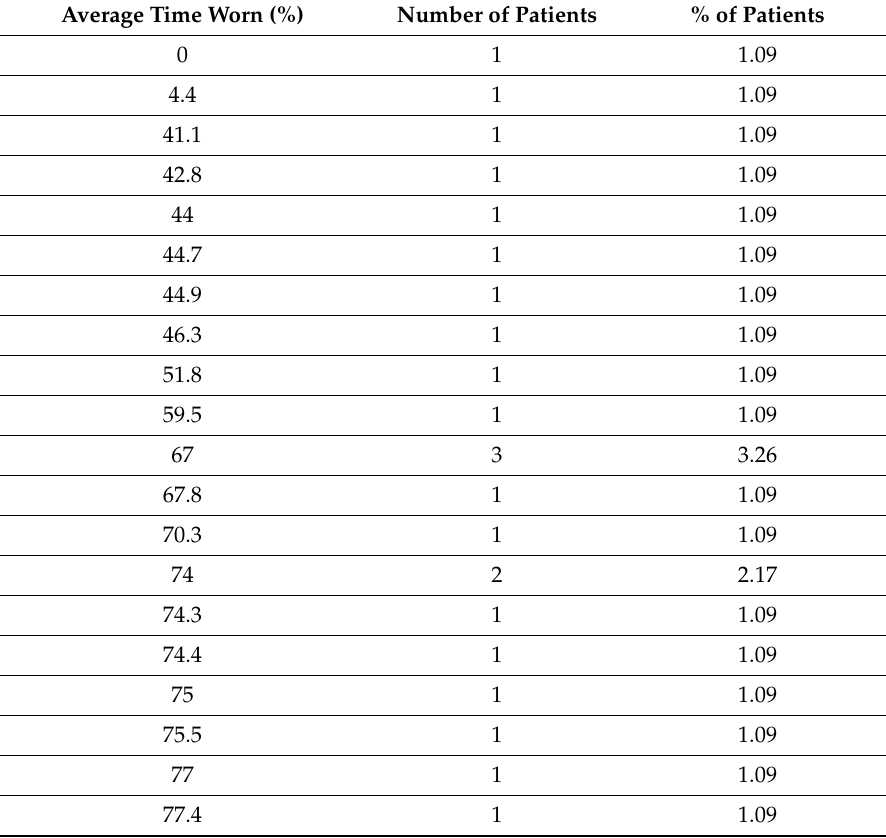
Table A1. For all patients who wore an ActiGraph ( n = 92), regardless of the wear